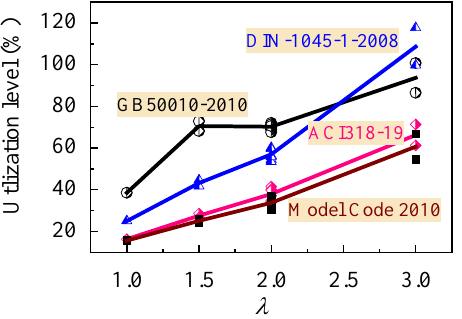
Figure 12. Utilization level of the shear strength attributed to the CRAC in design codes.